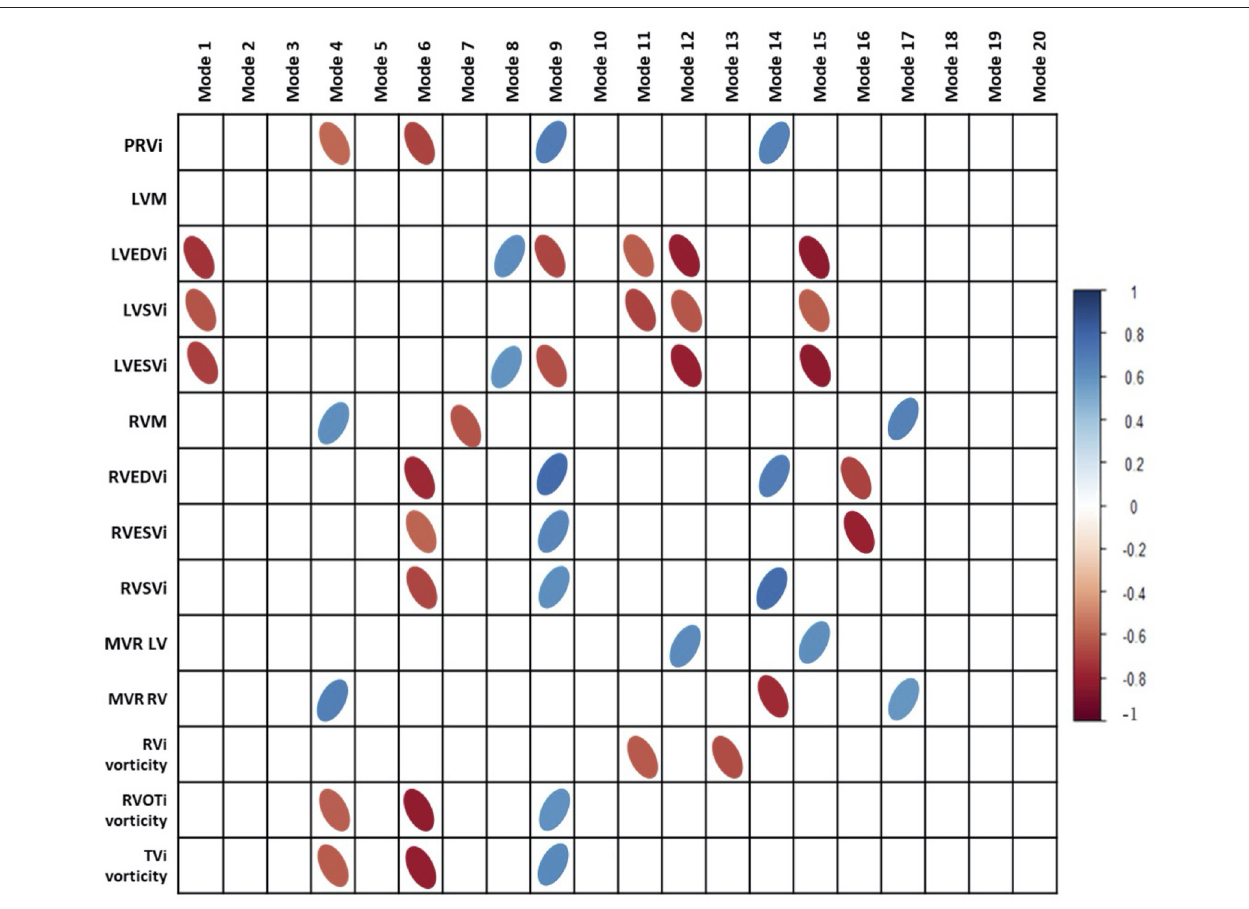
FIGURE 3 | Correlations of cardiac indices and vorticity with principal component analysis modes. PRVi, indexed pulmonary regurgitant volume; LVM, left ventricular mass; LVEDVi, indexed left ventricular end diastolic volume; LVSVi, indexed left ventricular stroke volume; LVESVi, indexed left ventricular end systolic volume; MVR, mass to volume ratio. Modes 9 and 6 Are the most correlated modes with aspects of cardiac metrics and vorticity. Bonferroni correction was done with all